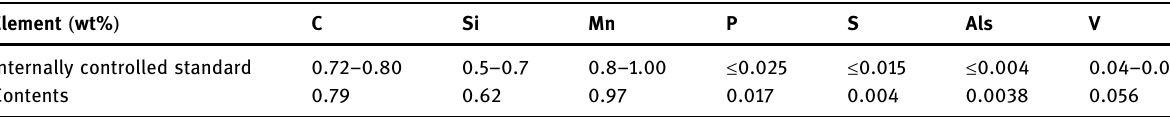
Table 1: Main composition of U75V heavy rail steel ( wt% )